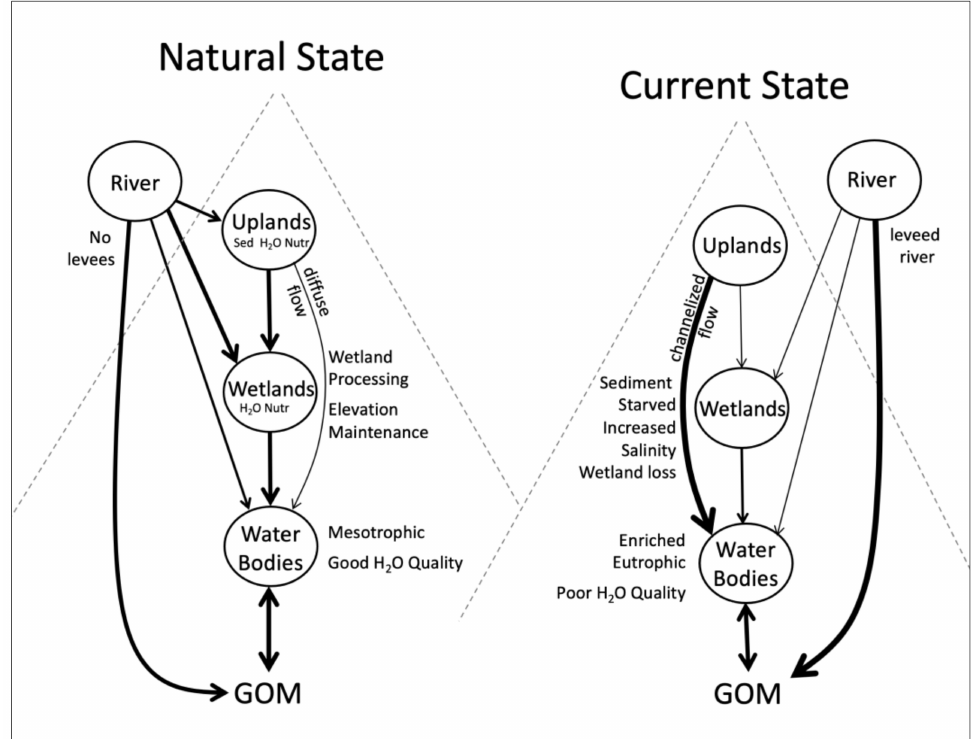
Figure 1. Simplified conceptual model of the Barataria Basin reflecting the triangular shape of the basin. There is net water flow from the upper basin to the Gulf of Mexico (GOM). Under natural conditions, river water entered the basin episodically, and rainfall runoff from elevated natural levees flowed mostly through wetlands to water bodies. Under current conditions, almost no river water enters the basin and upland runoff bypasses most